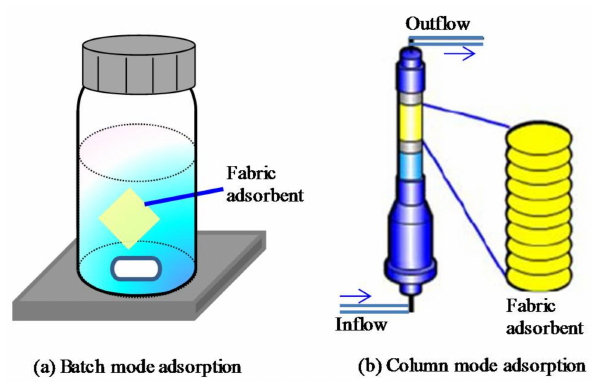
Figure 1. Batch and column mode